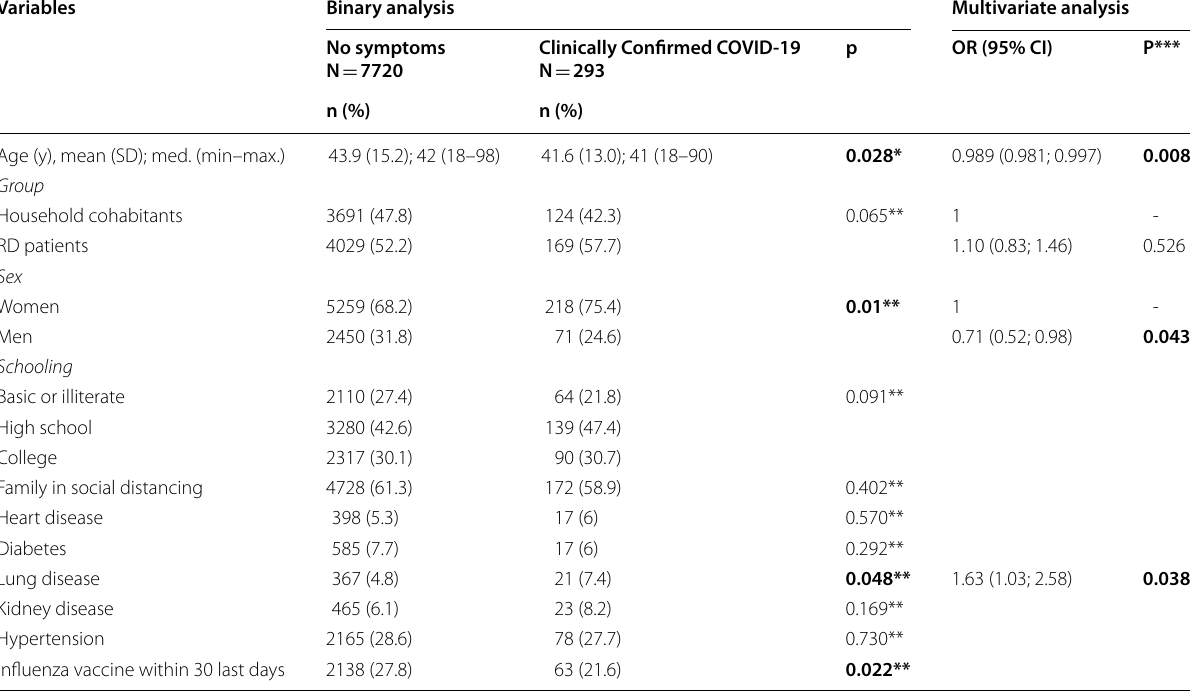
Bold values indicate statistical significance (p <